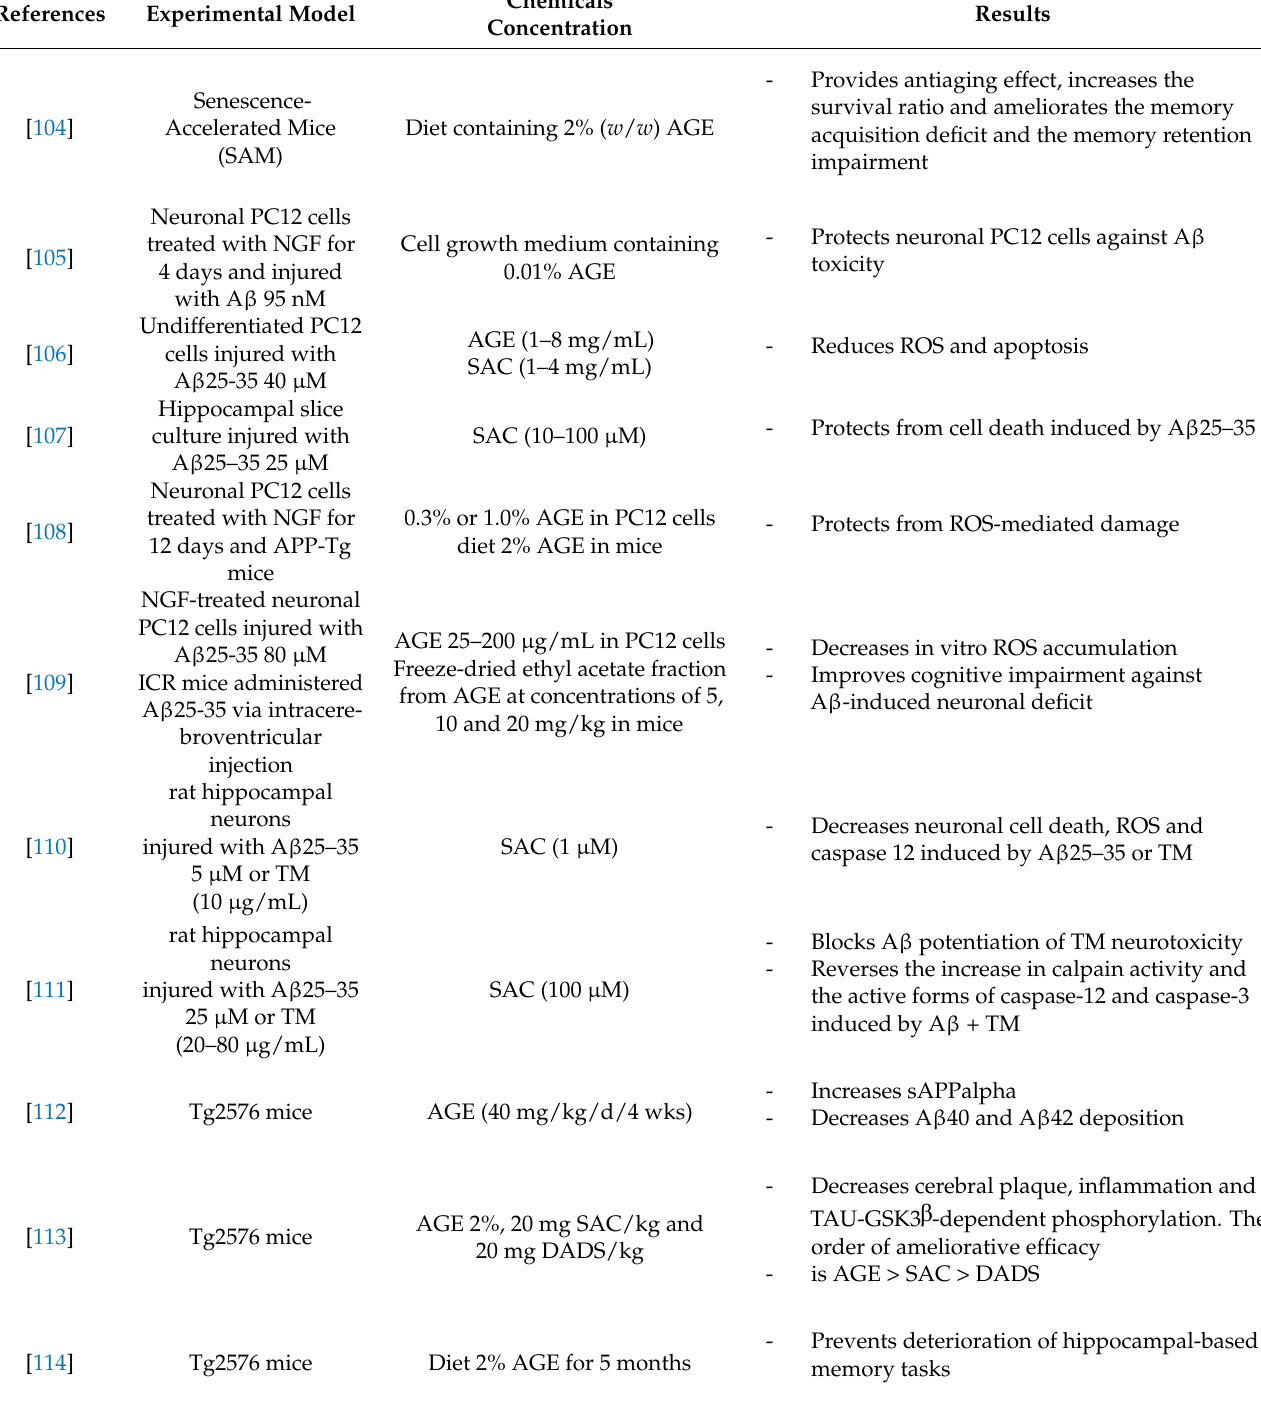
Table 2. Summary of experimental details, including model, chemical concentration and main results, of in vitro and in vivo studies of AGE and AD pathology.